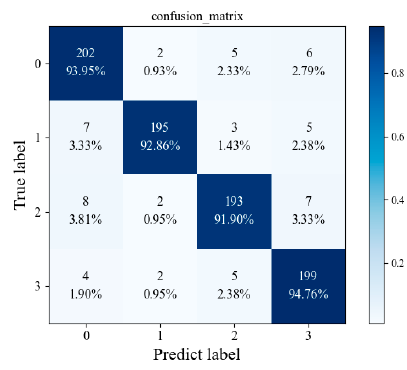
Figure 17. ResNet50 classification model.